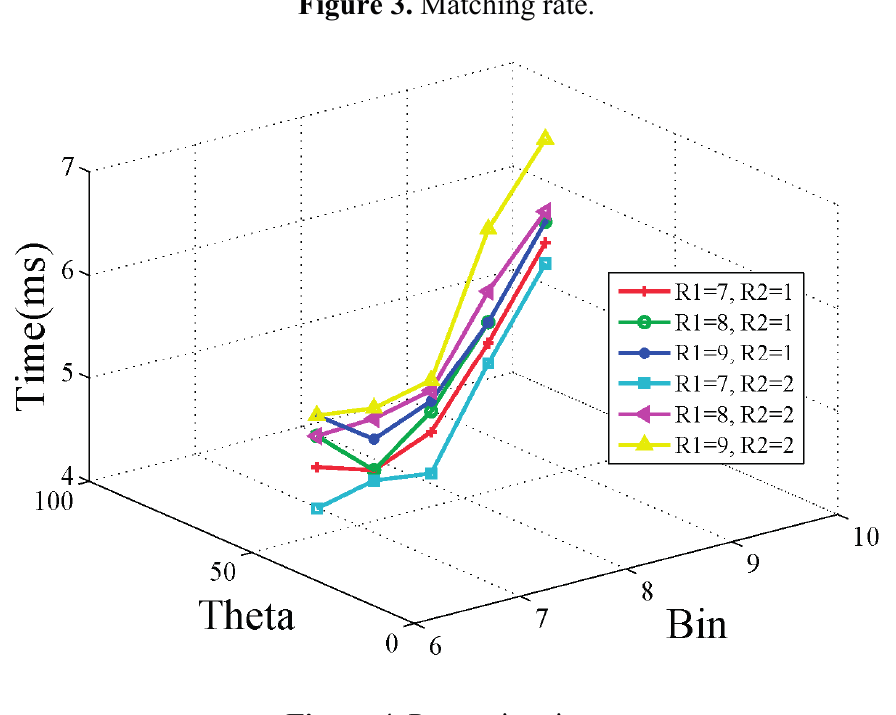
Figure 4. Processing